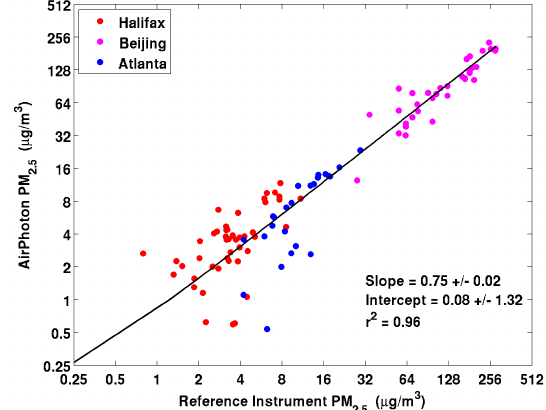
Figure A4. Scatter plot shows reduced major axis (RMA) regres- sion for Beijing, Atlanta, and Halifax PM 2 . 5 concentrations. Air- Photon filter samplers in Halifax, Atlanta, and Beijing were refer- enced using Partisol, PEM, and Laoying air sampler instruments,